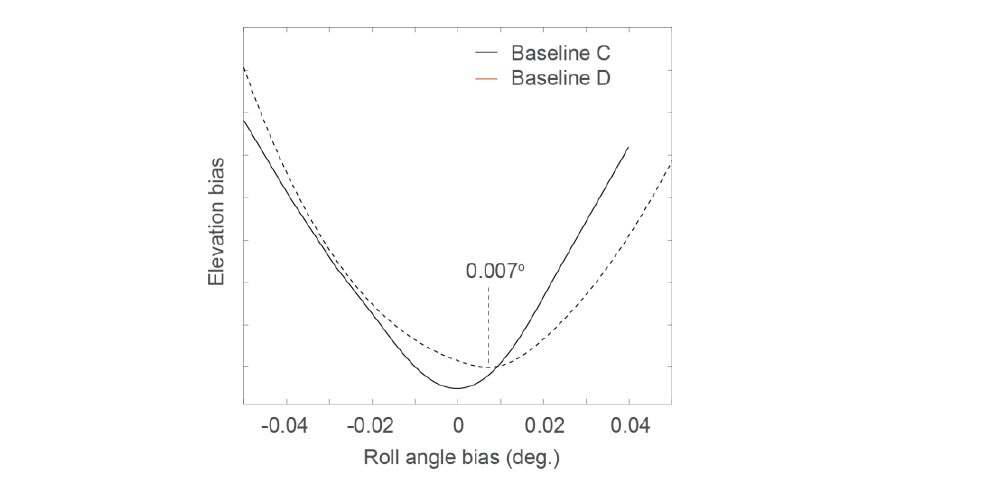
Table 2. Comparison of the roll bias results for